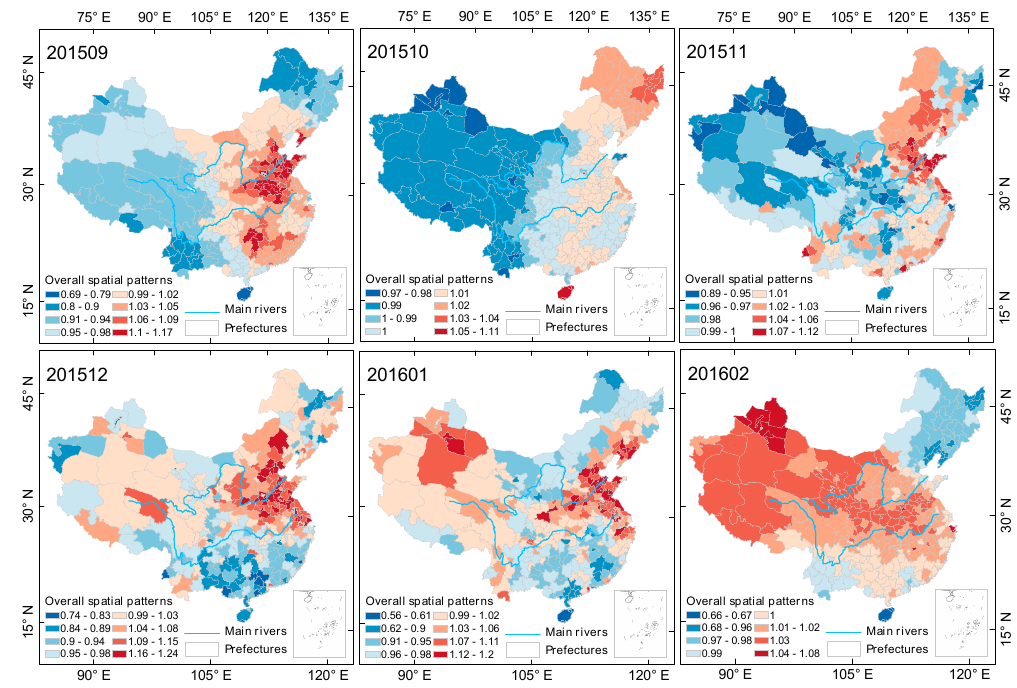
Figure 6. Evolution of spatial relativity of PM 2.5 pollution over Chinese mainland (not including Taiwan) during the autumn ‐ winter season of 2015–2016.